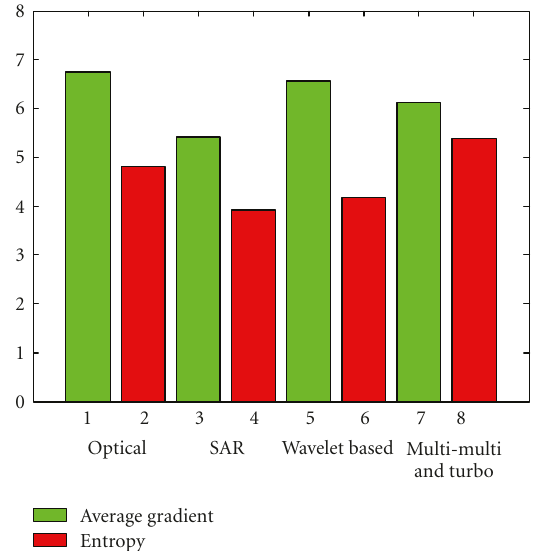
Figure 15: Comparative quantitative indicators for di ff erent algo-